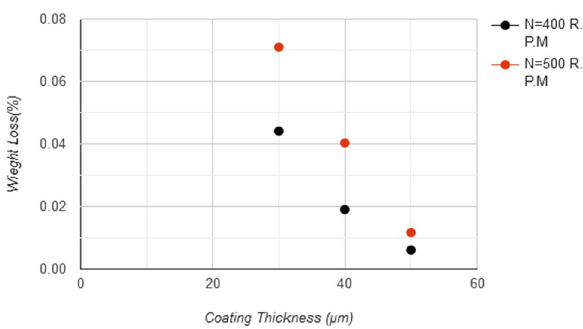
Figure 14. Coating layer thickness and weight loss for different rotational speed at force 20 N.